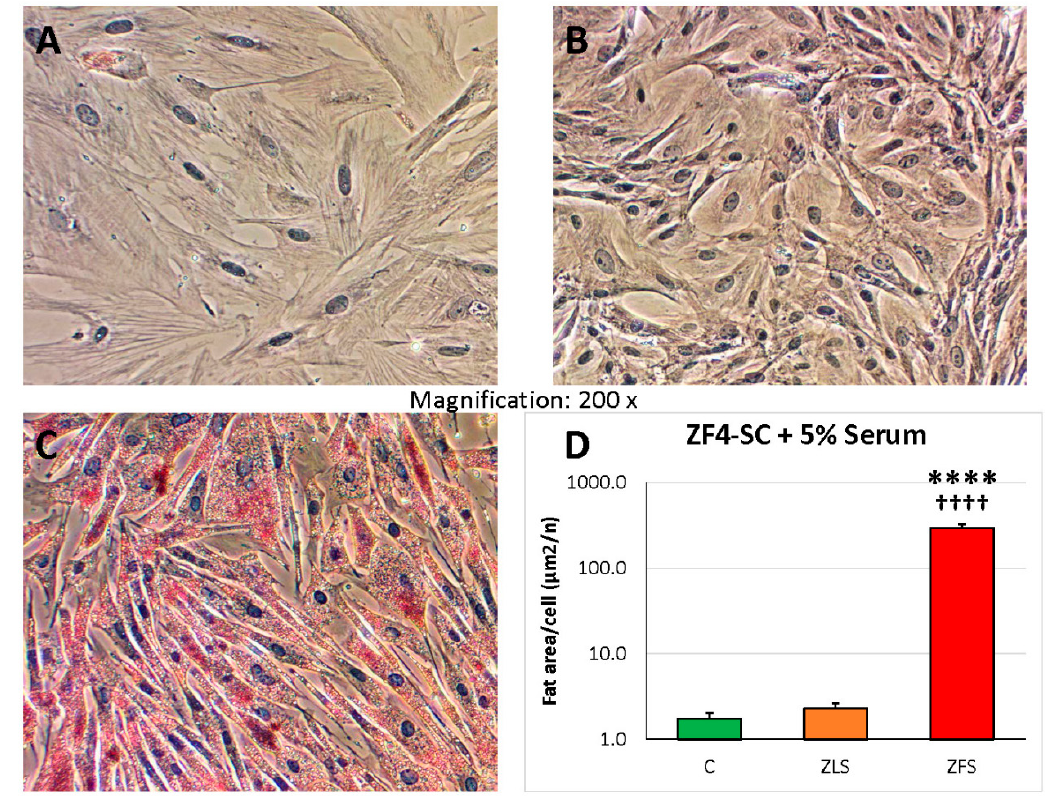
Figure 1. Incubation of ZF4-SC with ZF (Zucker fatty) serum (ZFS) induced intracellular infiltration by fat globules, whereas the one caused by ZL (Zucker lean) serum (ZLS) was very low and similar to the one in control with no addition. ZF4-SC were incubated for 4 days with no addition ( A ), or with added 5% ZLS from 20 weeks old ZL rats ( B ) or 5% ZFS from age-matched rats ( C ), and stained at 4–5 days with Oil Red O for fat infiltration. Pictures were taken at 200X, but QIA was applied to multiple fields at 100 × ( D ) showing the bar graph of red area (fat) per cell, in a semi-logarithmic scale, C: no serum addition; **** p ≤ 0.0001 (C vs. ZFS); ++++ p ≤ 0.0001 (ZFS vs. ZLS).